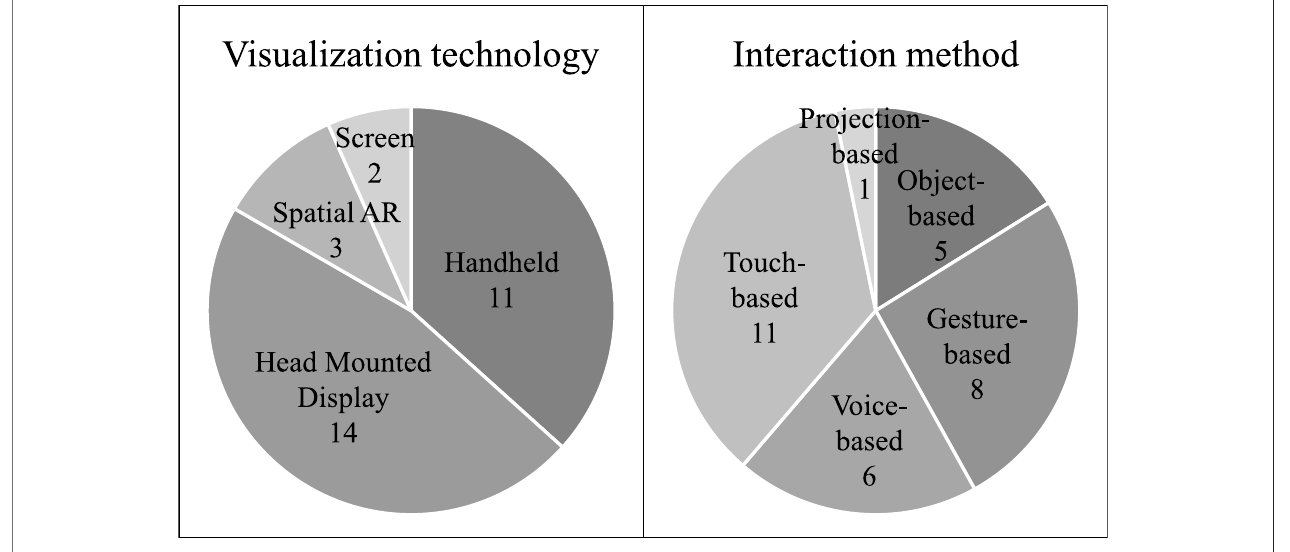
FIGURE 3 | Analysis results of the contributions regarding visualization technology, interaction